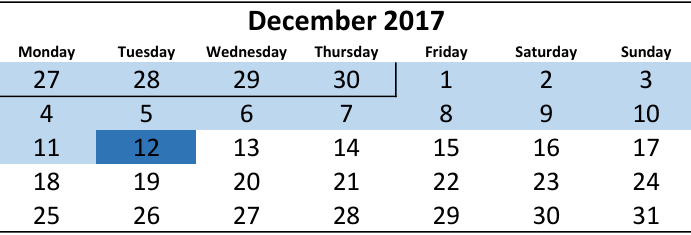
Figure 5. Selected day for the model predictive control (MPC) case study (blue color), with thermal history indicated in light